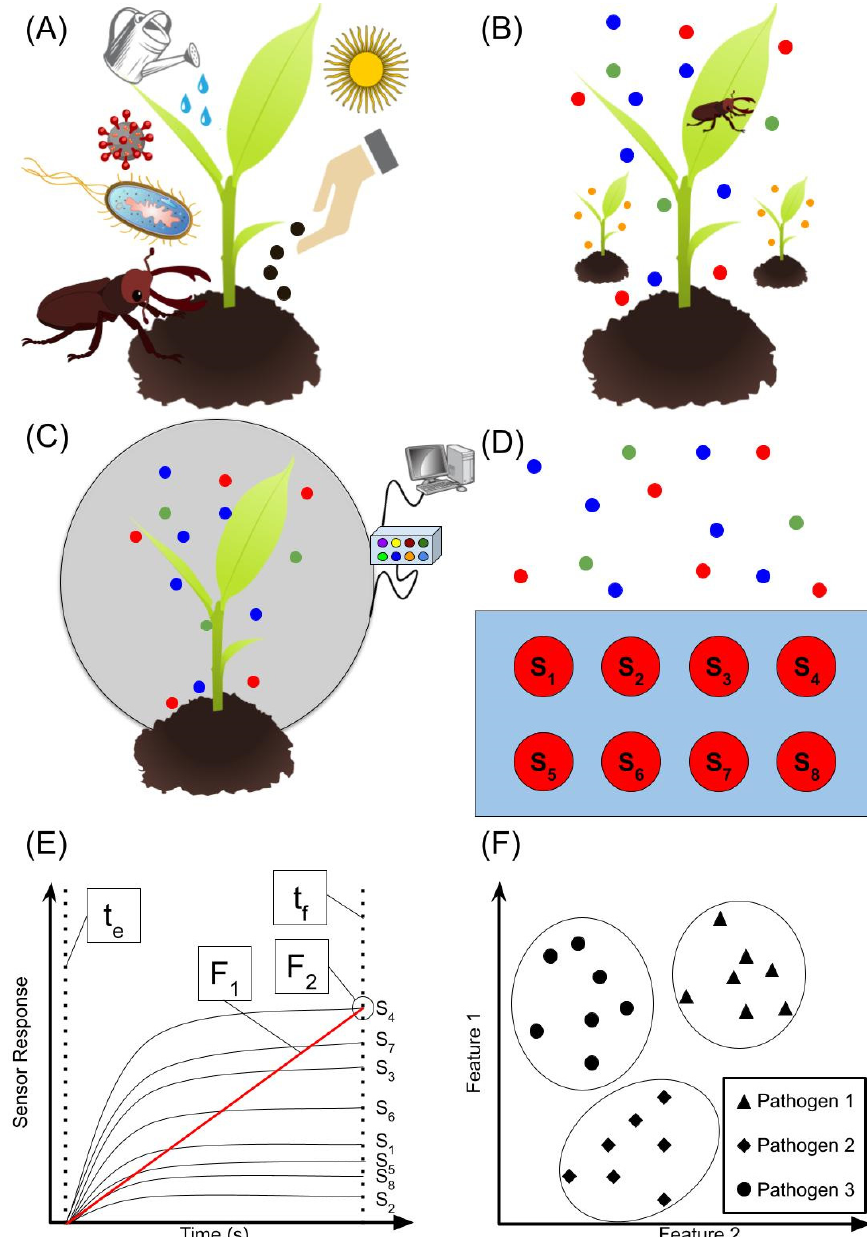
Figure 1. Overview of plant pest and disease detection by way of VOC monitoring using an electronic nose for example. ( A ) Effects of external factors on VOCs. VOCs such as acetone and ethanol are continuously released from plant tissue due to external factors such as temperature, available nutrition, or damage by pests or viral and bacterial infections [13]. ( B ) VOCs for plant communication and defense. VOCs released by plants allow communication with insects and other plants (i.e., attracting pollinators or signaling danger to neighbouring plants) [14,15]. ( C ) VOC collection. The profile VOCs released by plant tissues at any given moment can be collected using a headspace sampling method such as static headspace sampling (shown here) or dynamic headspace sampling [16,17]. ( D – F ) Basic working principle of an electronic nose. ( D ) An array of different sensors (S 1 –S 8 , each selective to different analytes) exposed to headspace sample. ( E ) Example of a response curve from an electronic nose with eight sensors (S 1 –S 8 ) from exposure time, t e , to final time, t f , (i.e., 200 s) with features 1 and 2 (F 1 , F 2 ). ( F ) Sample feature plot for three pathogens (1–3) that affect the same plant (such as Ralstonia solanacearum , Clavibacter michiganensis , and Pectobacterium carotovorum , causes of different types of rot in potatoes).